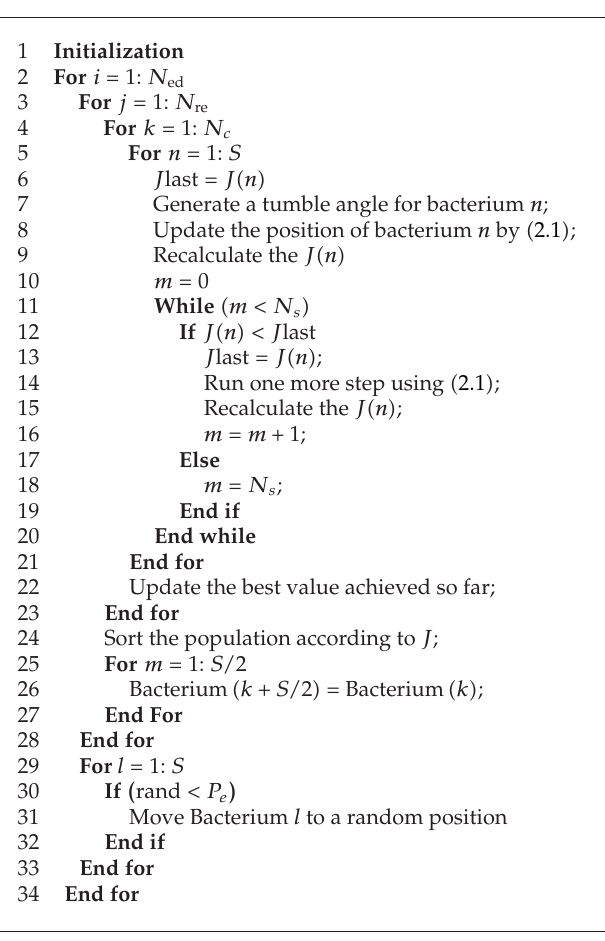
P SEUDOCODE 1: Pseudocode of original BFO